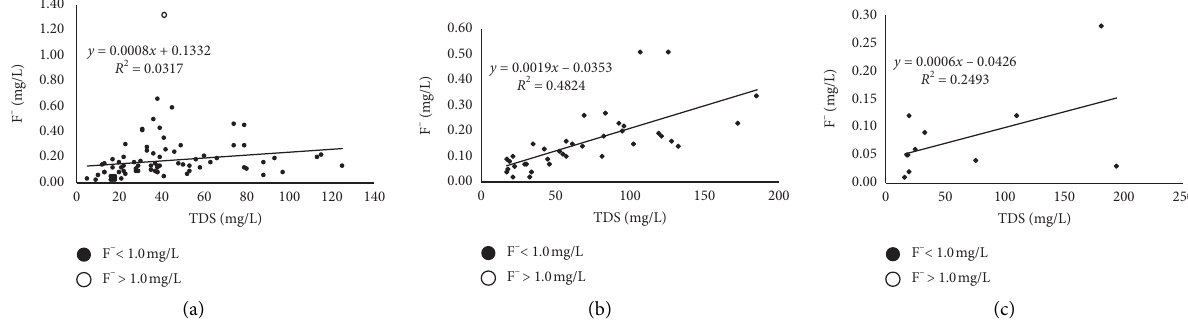
Figure 5: Relationship between F − and TDS in groundwater of different subsystems. (a) Groundwater subsystem of Suishui River.